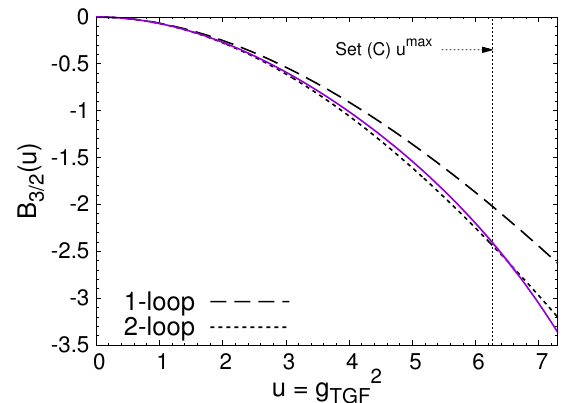
Figure 2 . The discrete beta function in the continuum limit (solid purple line) obtained with N max = 3 from the set (C) together with the one- and two-loop analytic results. The statistical error band (light purple shade) for the result is underlaid behind the solid purple line, but is almost identical to the width of the